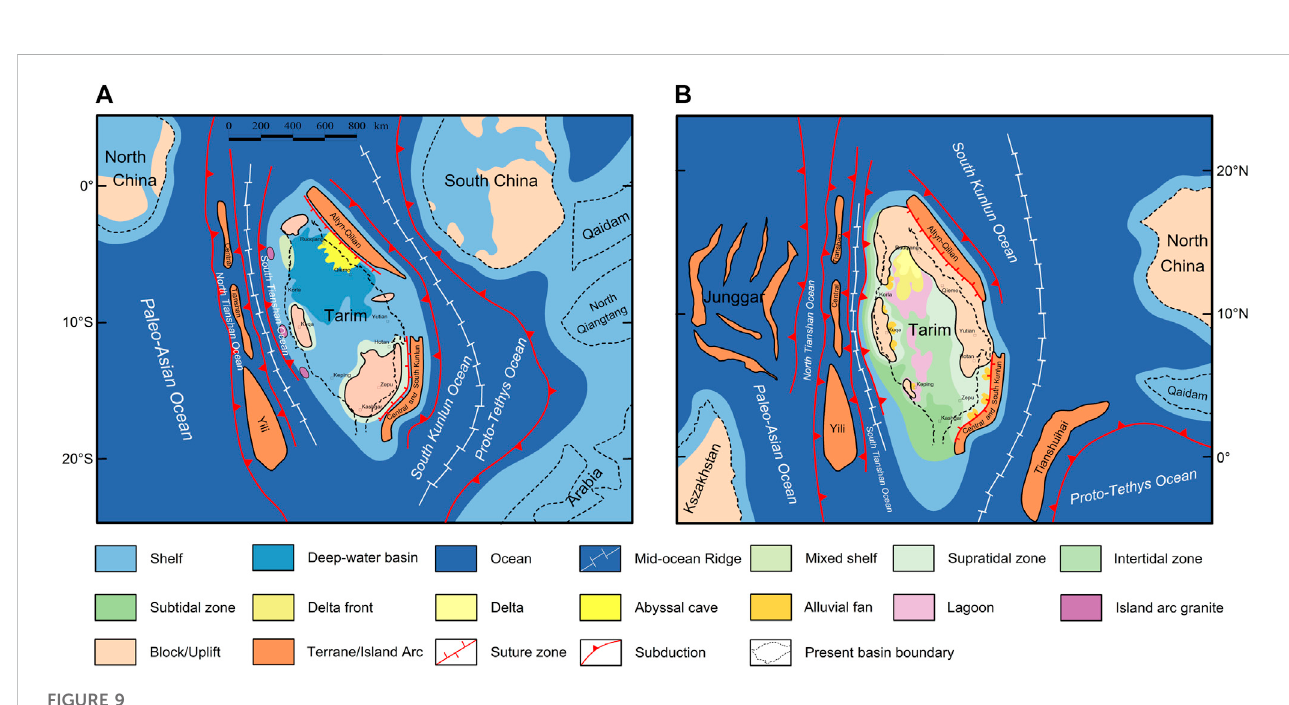
FIGURE 9 Tectono-paleogeography of Tarim and adjacent areas in late Ordovician (A) and late Silurian (B)